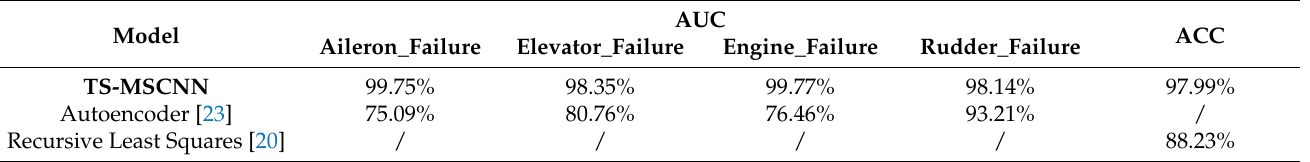
Table 7. The accuracies of the TS-MSCNN and the other latest algorithm in multiclass